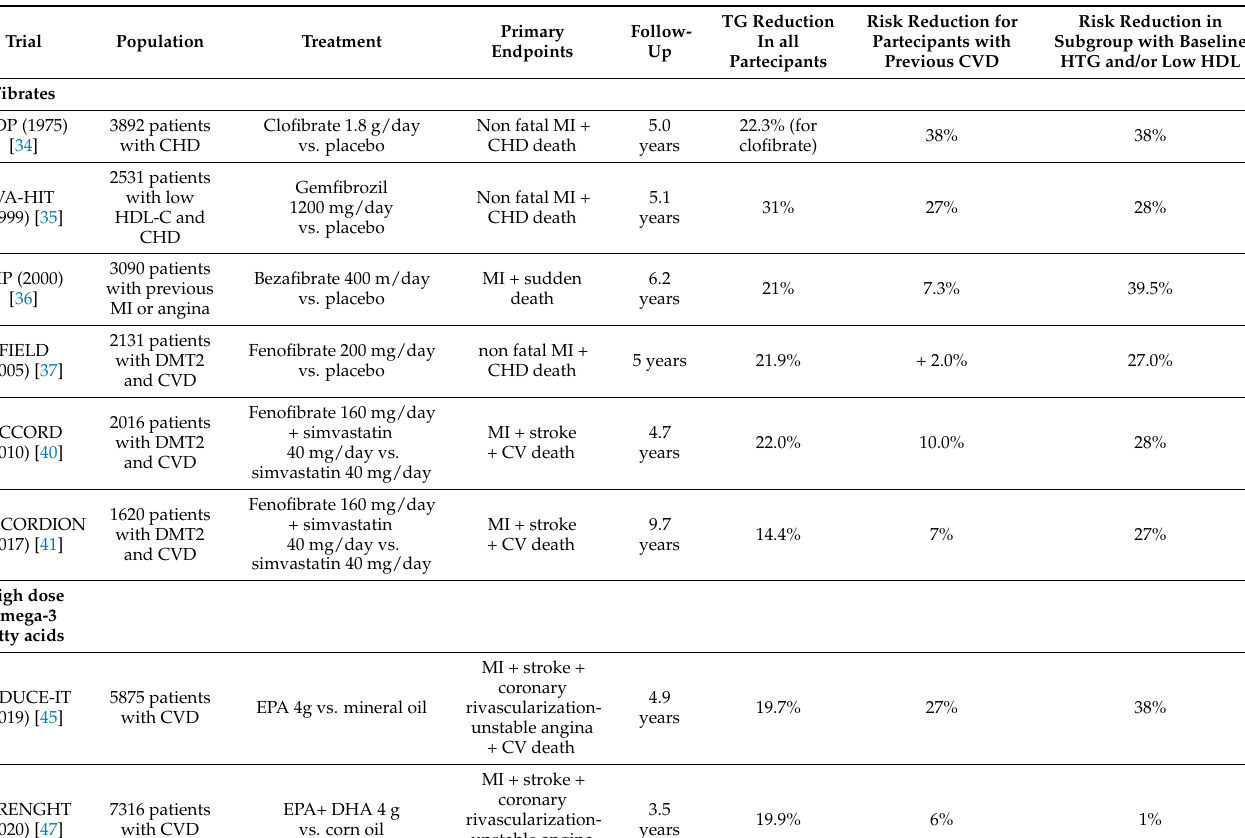
Table 2. Randomized cardiovascular outcomes study with triglycerides-lowering therapy in patients with coronary artery